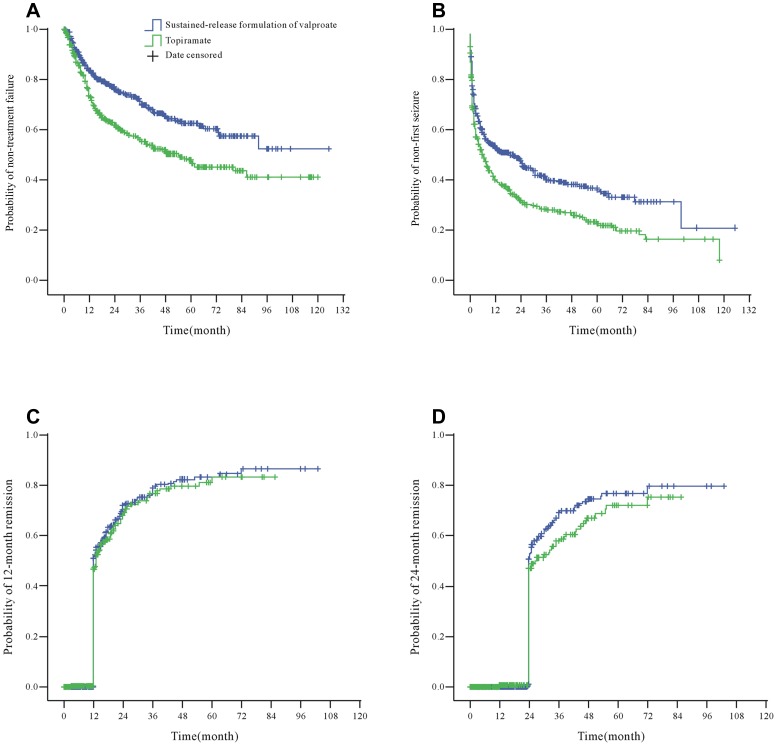
Kaplan-Meier estimates of clinical outcomes.A: Probability of non-treatment failure; B: Probability of non-first seizure; C: Probability of 12-month remission of seizures; D: Probability of 24-month remission of seizures.